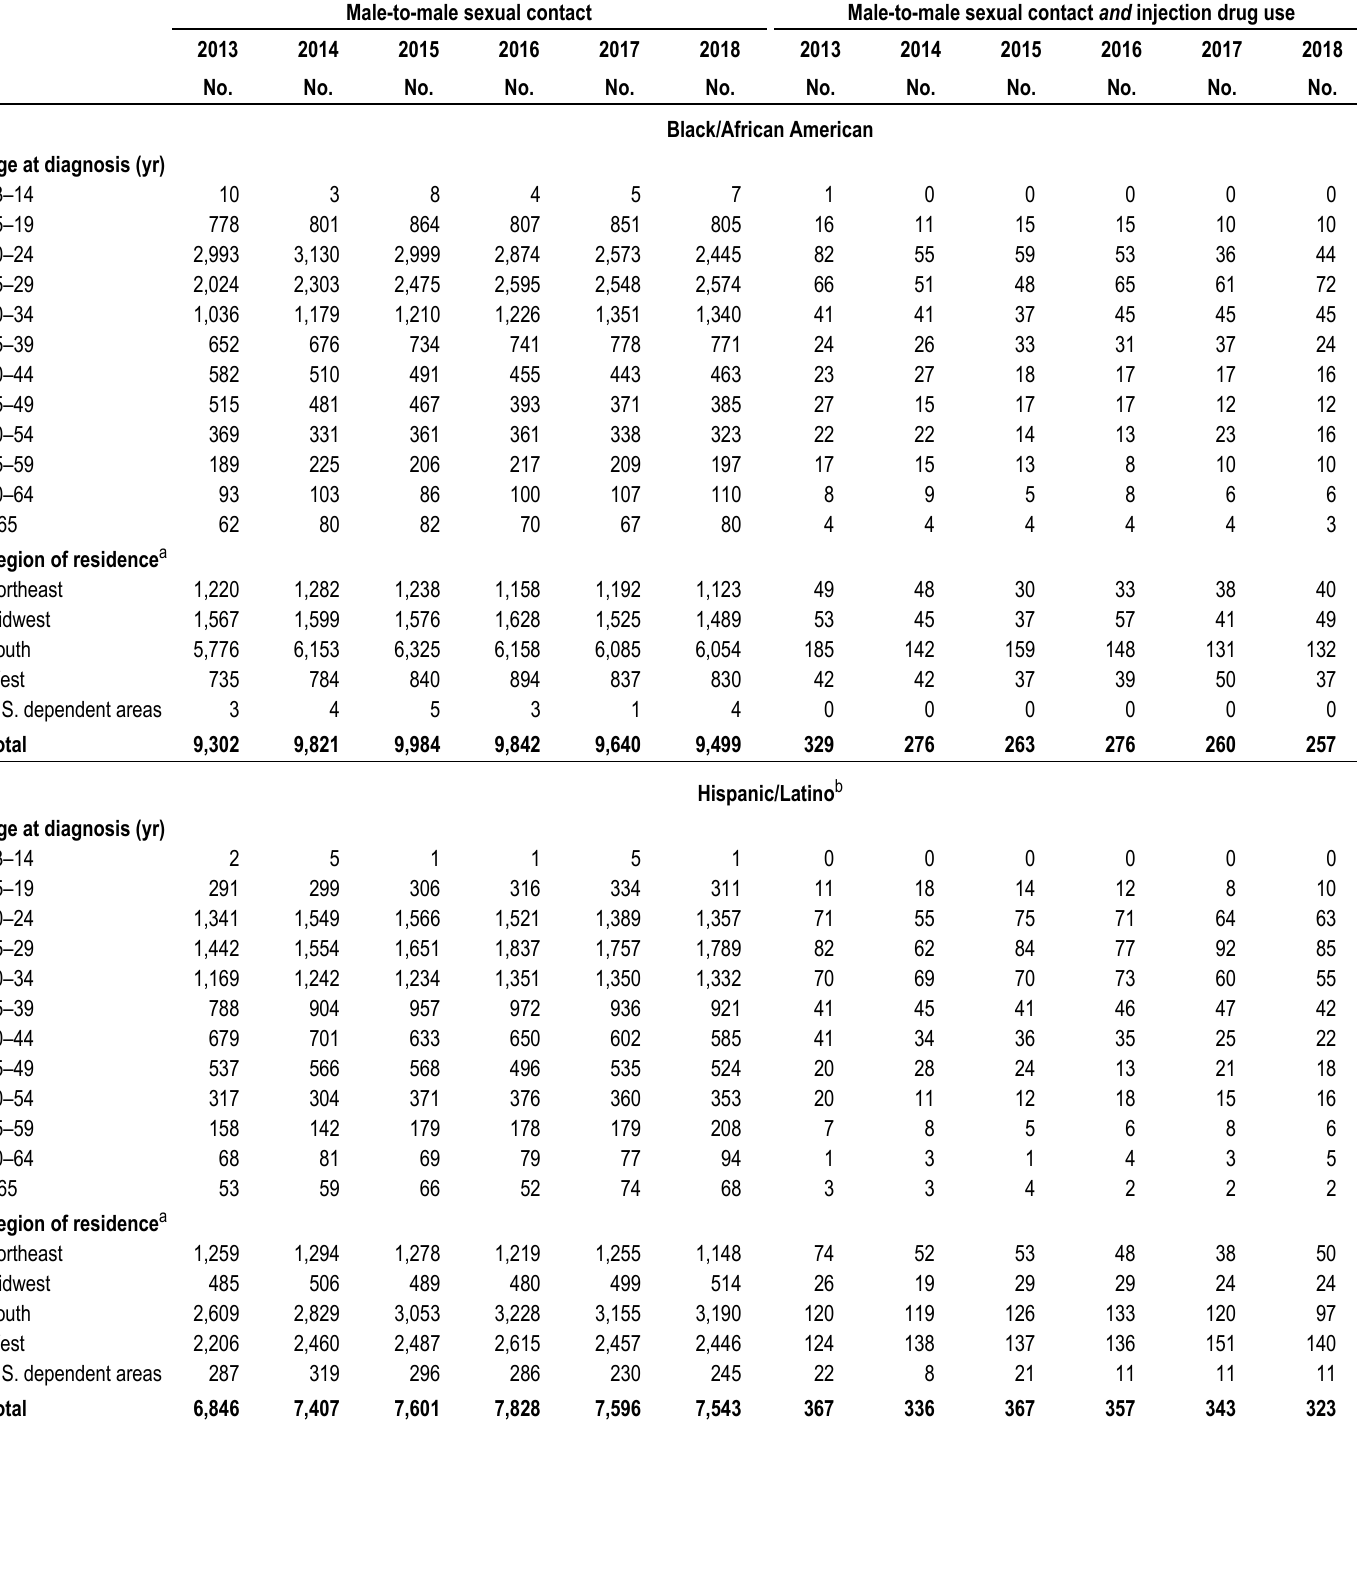
Table 7b. Diagnoses of HIV infection attributed to male-to-male sexual contact and male-to-male sexual contact and injection drug use, by selected characteristics, 2013–2018—United States and 6 dependent areas (cont) Male-to-male sexual contact Male-to-male sexual contact and injection drug